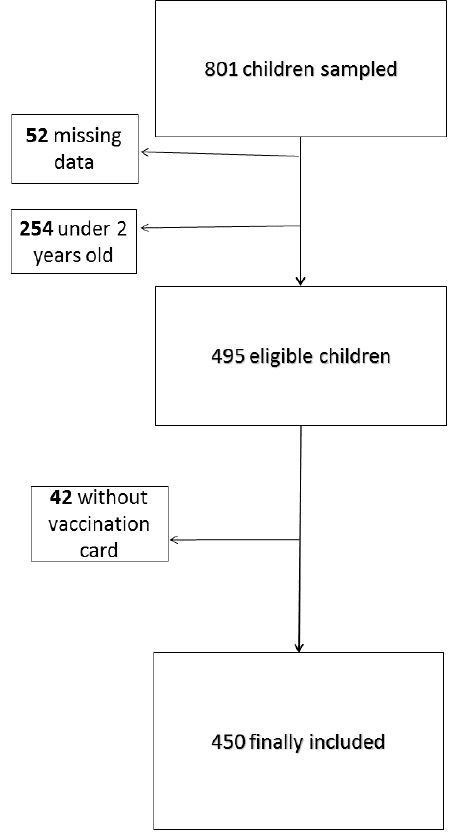
Figure 1. Flow Figure 1. Flow chart.